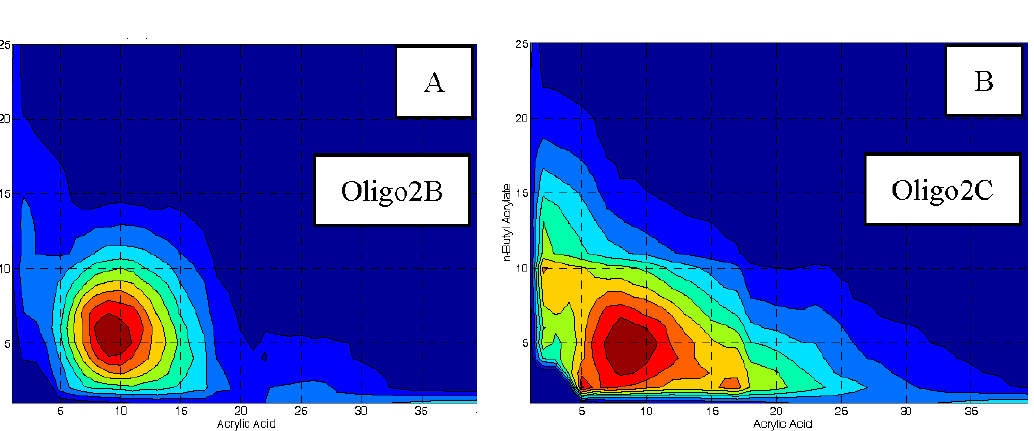
Table 1. Characterization of co-oligomer with NMR and GPC.